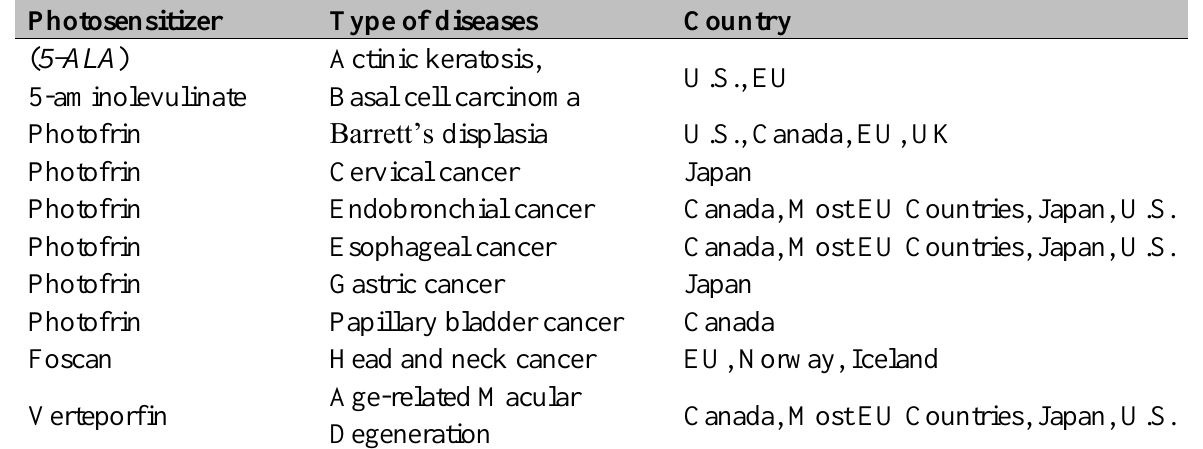
Table 1. Photosensitizers approved in human